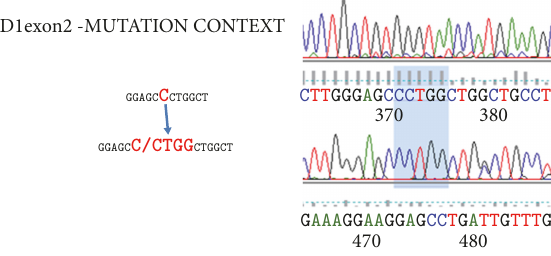
Figure 1: Representation of the novel 4bp insertion mutation in SMPD1 gene in exon 2 in family 2 in parental